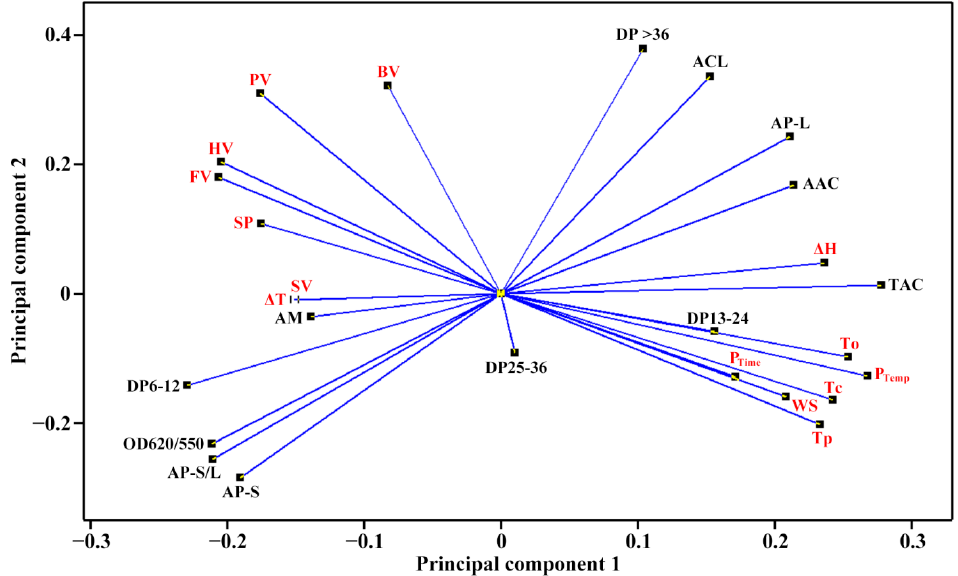
Figure 5. Loading plot of PCA based on the molecular components and heat properties of C-type starches. The abbreviations are listed in Tables 2, 3, 5 and 6. The molecular components are in black, and the heat properties are in red.